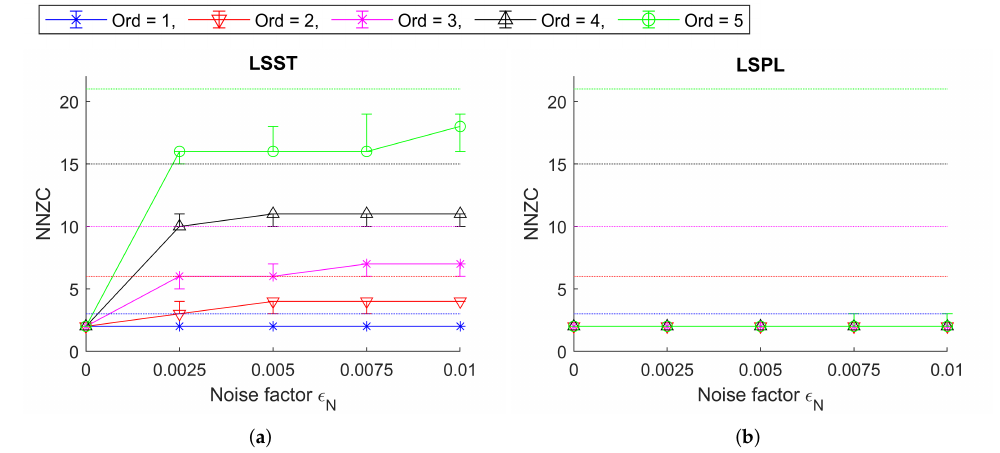
Figure 4. Median and quantile of NNZC with methods ( a ) LSST and ( b ) LSPL. The horizontal dotted lines mark the maximal numbers of candidate functions for each polynomial